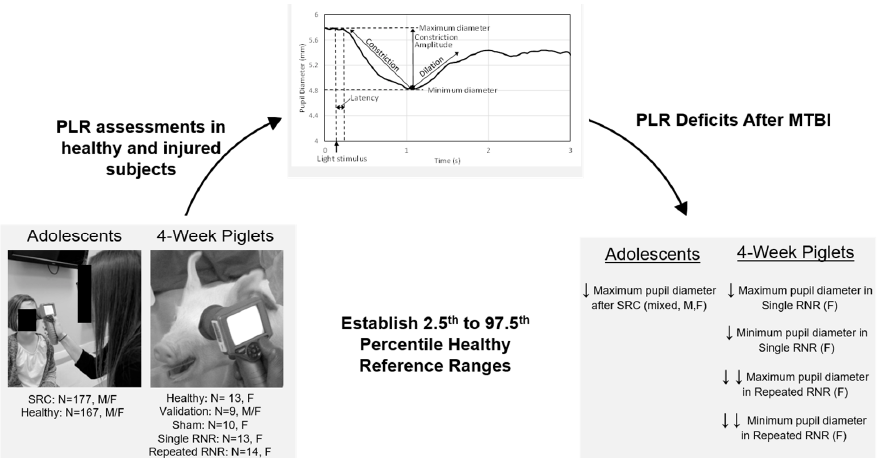
Figure 5. Illustration of PLR cohorts and comparison of main findings for adolescent children with and without an SRC and healthy and experimental RNR 4 week old piglets. M = male, F = female. Mixed refers to mixed head injury mechanisms causing the SRC. A greater number of PLR deficits were observed in controlled piglet RNR studies, with repeated RNR having more severe deficits.